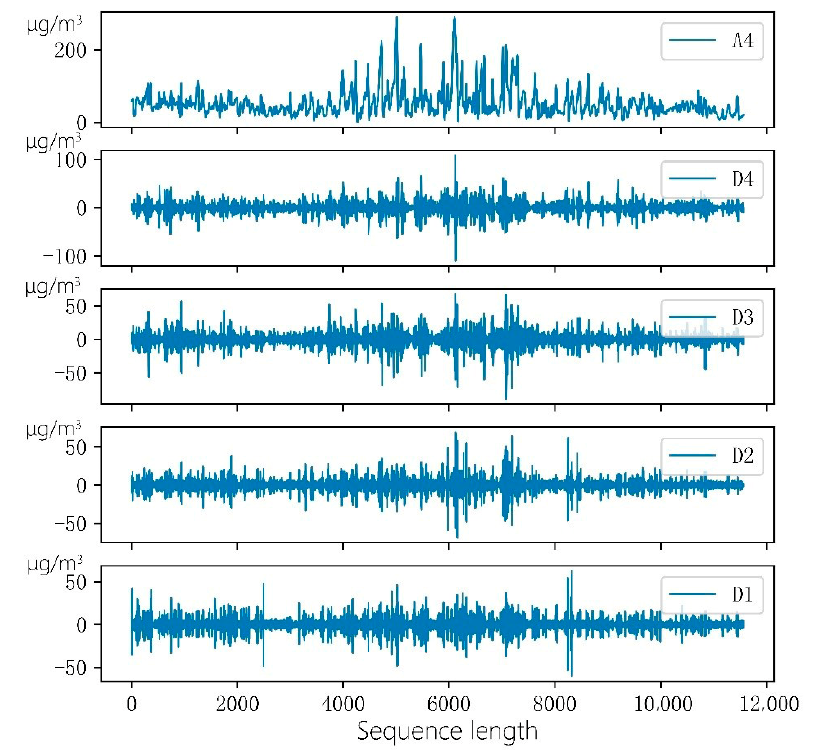
Figure 2. Results of wavelet decomposition.